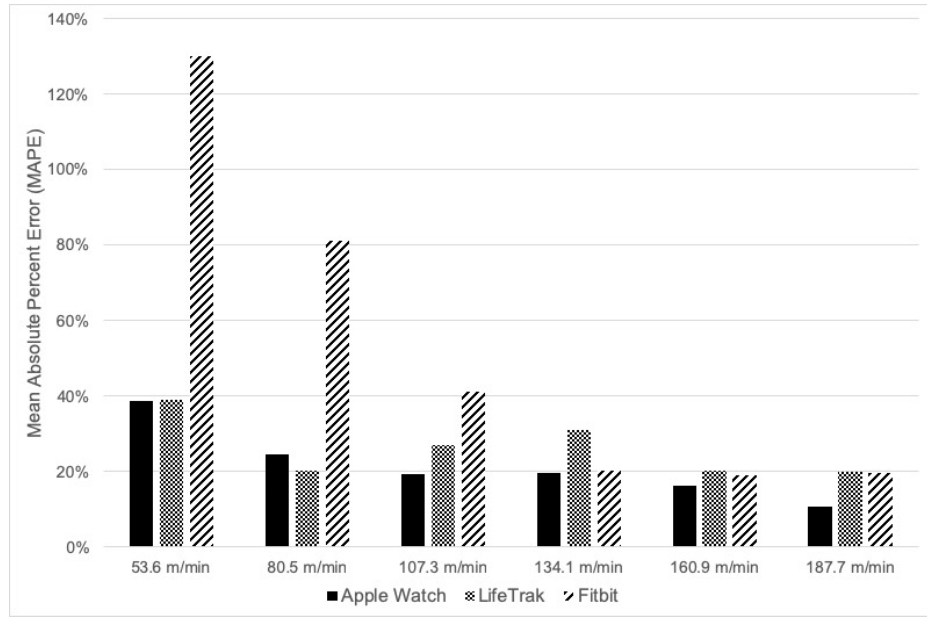
Figure 1. Mean Absolute Percent Error scores across treadmill